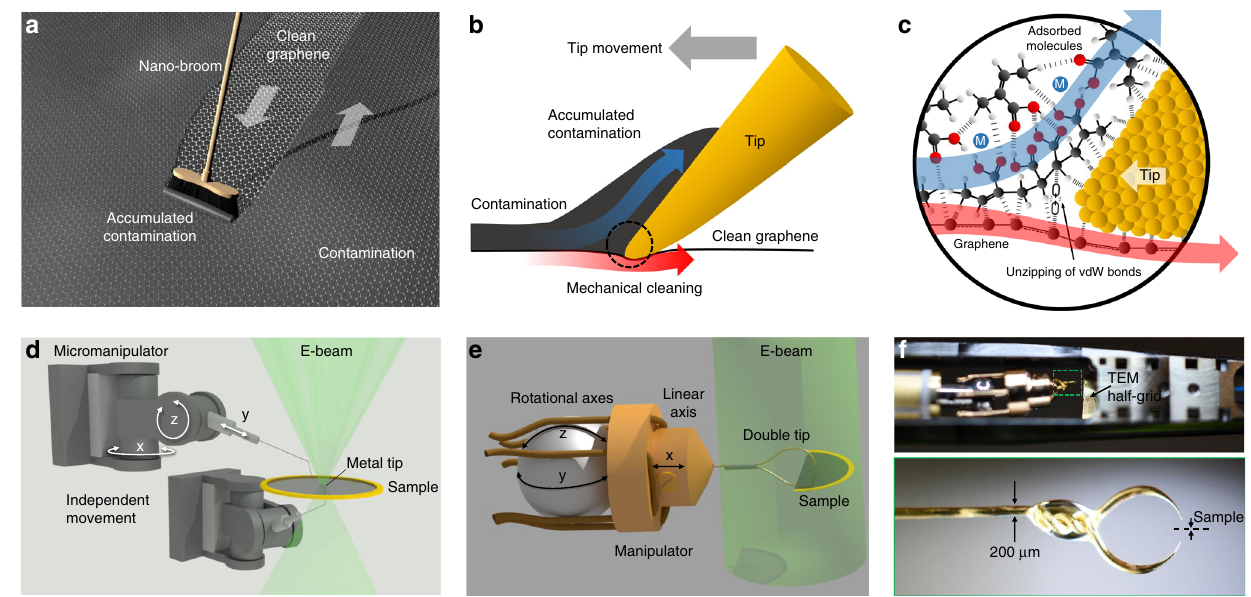
Fig. 1 General concept and technical implementation of mechanical cleaning. a Artistic representation of the cleaning approach: the mechanism of cleaning with a broom is transferred to the nanoscale. b The “ broom ” becomes a small metal tip that separates adsorbed contamination from the graphene substrate. c The tip unzips weak van der Waals type bonds between contaminants and the substrate while the strong intralayer bonds of graphene stay intact. d Setup in the SEM: two independent three-axis micromanipulators are used, one dedicated for each side of a suspended membrane. In TEM, only a single manipulator is available ( e ) due to size constraints. This manipulator is therefore out fi tted with a crescent-shaped double tip to reach both sides of suspended membranes. f Sample and manipulator in the TEM holder (top) and a photograph of a representative double tip